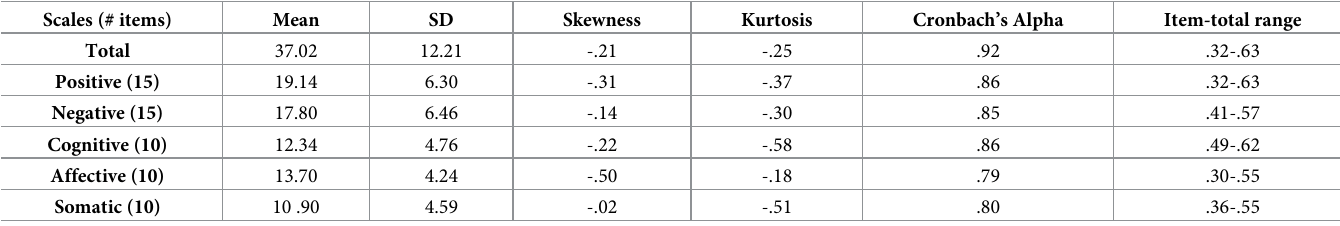
Table 3. Mean, SD, skewness, kurtosis, Cronbach’s alpha and range of item-total correlations for all CASES scales. Scales (# items)